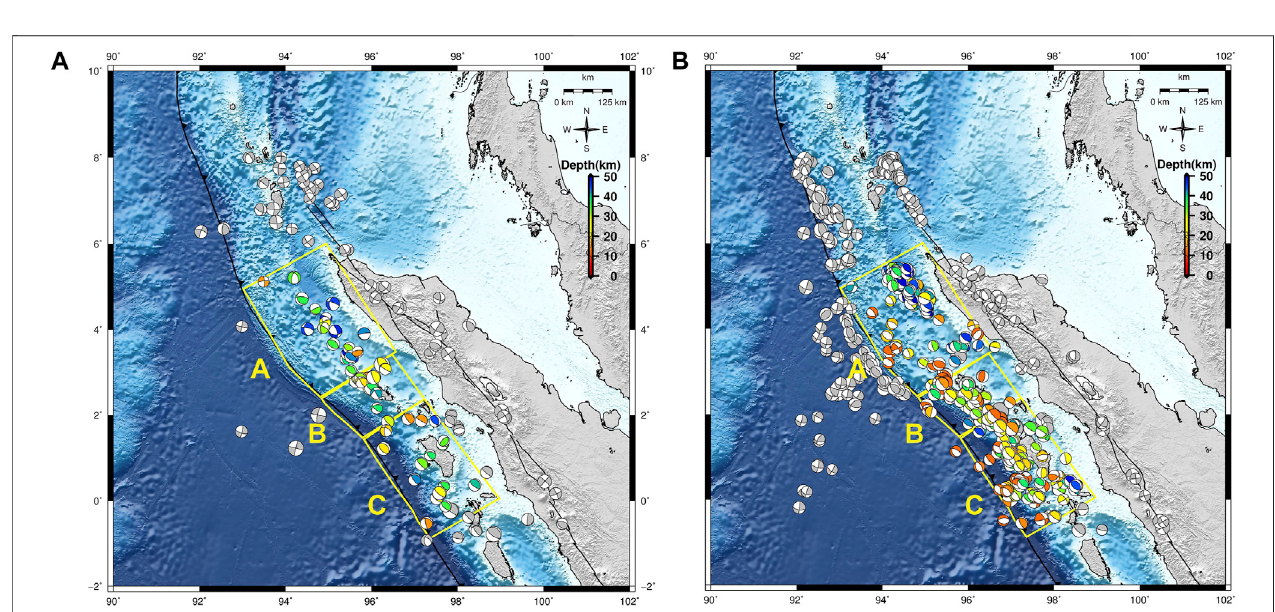
FIGURE 3 | Focal mechanism distributions in northern Sumatra for the pre-mainshock (A) and post-mainshock seismicity (B) . The yellow polygons show the segments used to group focal mechanisms for estimation of stress parameters in outer forarc. Background bathymetry/topography is from GEBCO (Kapoor, 1981).